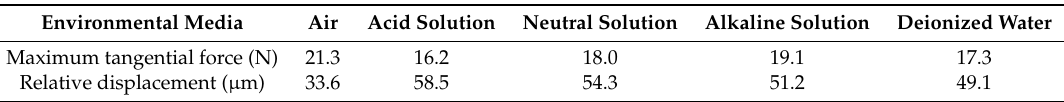
Table 3. The maximum tangential force and relative displacement at loading cycles 20,000 in di ff erent environmental